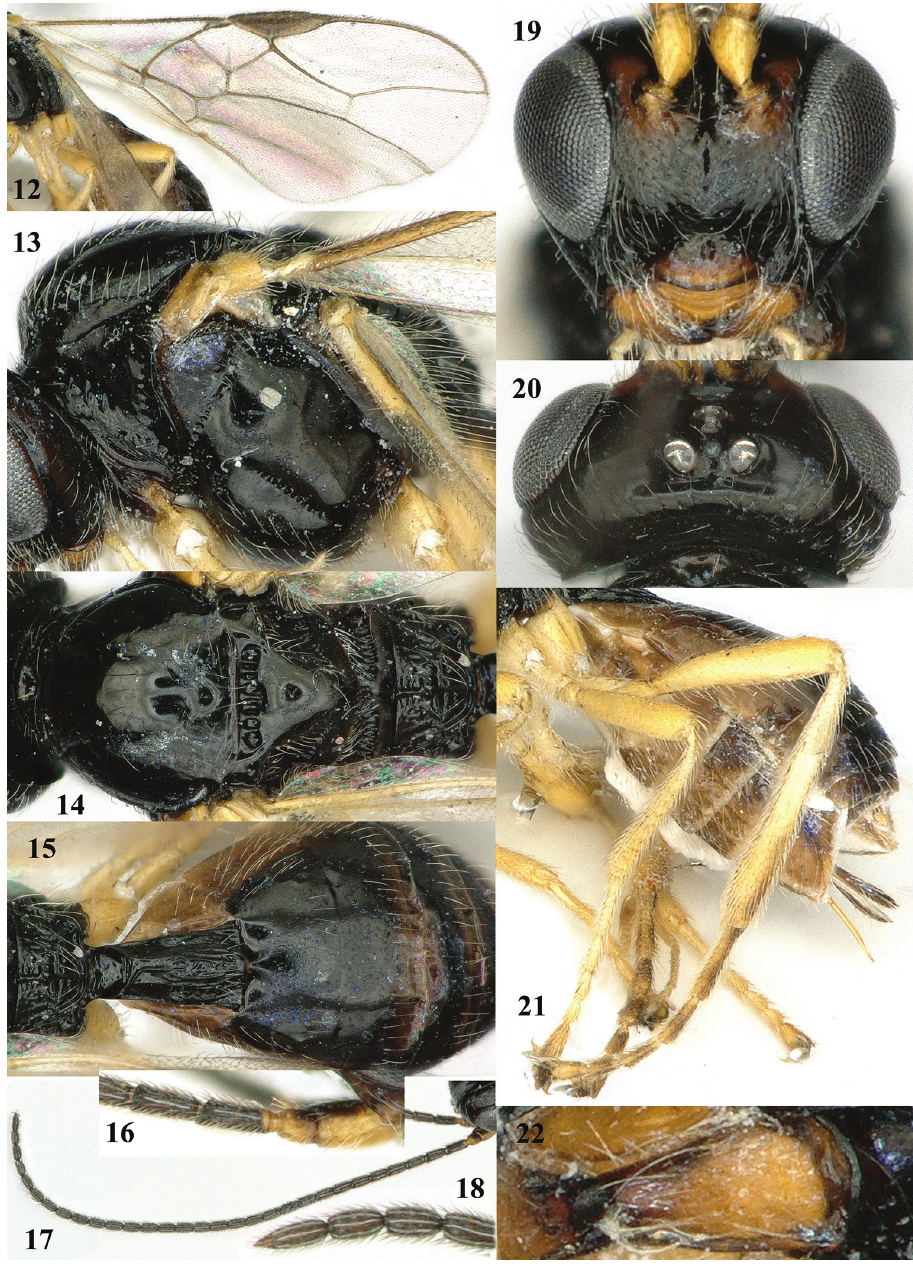
Figures 12–22. Rhogadopsis cracentata sp. n., female, holotype. 12 wings 13 mesosoma lateral 14 meso- soma dorsal 15 first-third metasomal tergites dorsal 16 base of antenna 17 antenna 18 apex of antenna 19 head anterior 20 head dorsal 21 hind leg 22 mandible